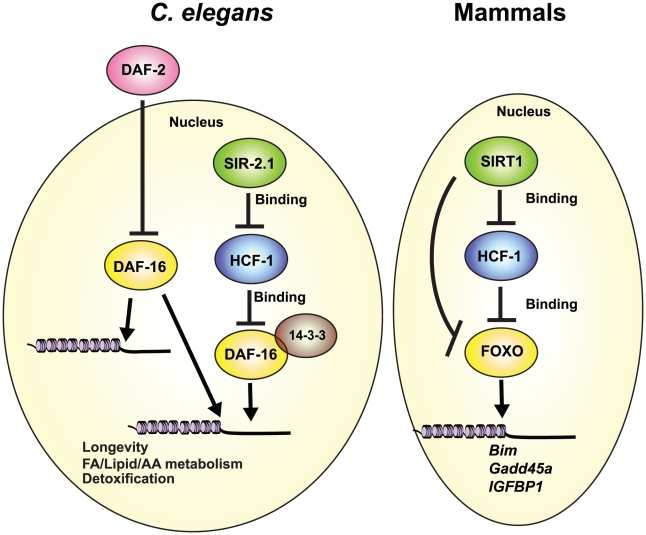
Conserved regulation of DAF-16/FOXO by HCF-1 and SIR-2.1/SIRT1.We propose that C. elegans HCF-1 and SIR-2.1 coordinate to fine-tune the transcriptional activity of DAF-16 on a distinct subset of potential target genes. DAF-16 target genes responsive to the hcf-1/sir-2.1 pathway largely overlap with a small subset of IIS-regulated genes, and are specialized in longevity determination, cellular defense, and lipid/fatty acid/amino acid homeostasis. HCF-1 likely represses DAF-16 by forming a complex with SIR-2.1 and 14-3-3, and antagonizing their abilities to stimulate DAF-16. This functional relationship is highly conserved as mammalian HCF proteins also repress the expression of multiple FOXO/SIRT1 target genes and reside in protein complexes with SIRT1 and FOXO3. Our results highlight HCF proteins to be key components of the regulatory network linking SIR-2.1/SIRT1 and DAF-16/FOXO in diverse organisms.